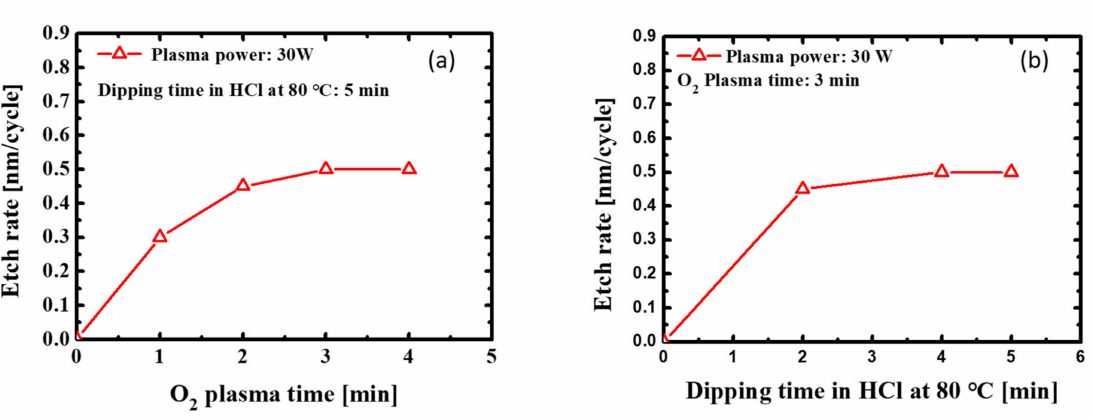
Figure 6. Etch rate per cycle of the digital etching performed under ( a ) varying O 2 plasma times and fixed HCl dipping time and ( b ) varying HCl dipping times and fixed O 2 plasma